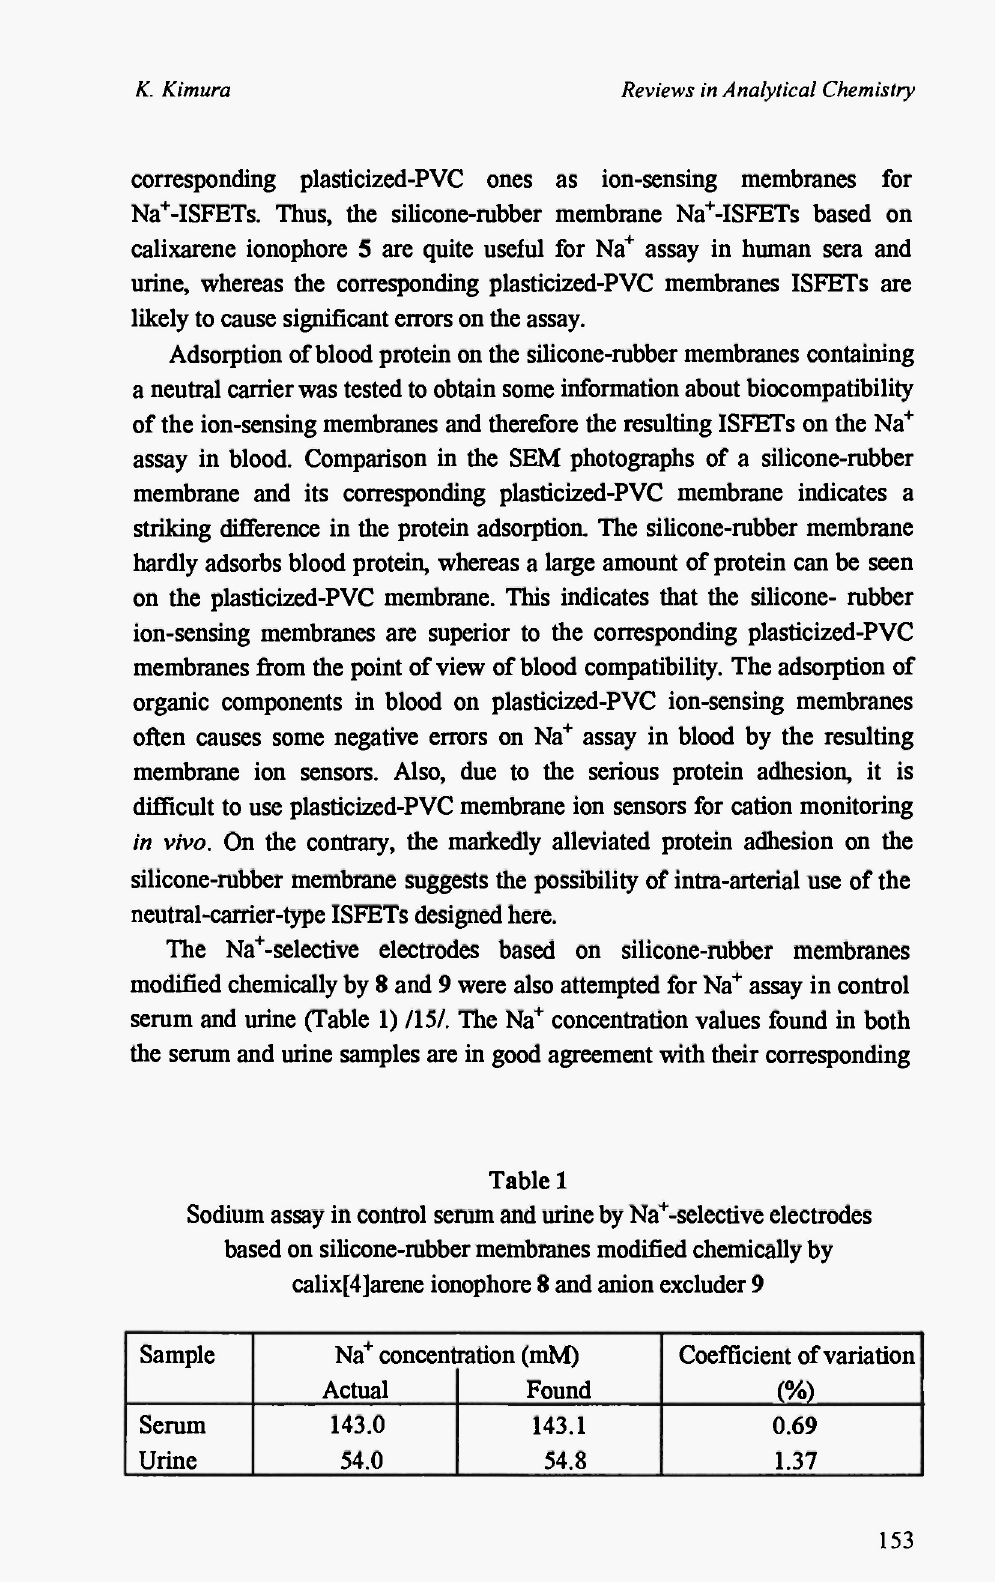
Sodium assay in control serum and urine by Na + -selective electrodes based on silicone-rubber membranes modified chemically